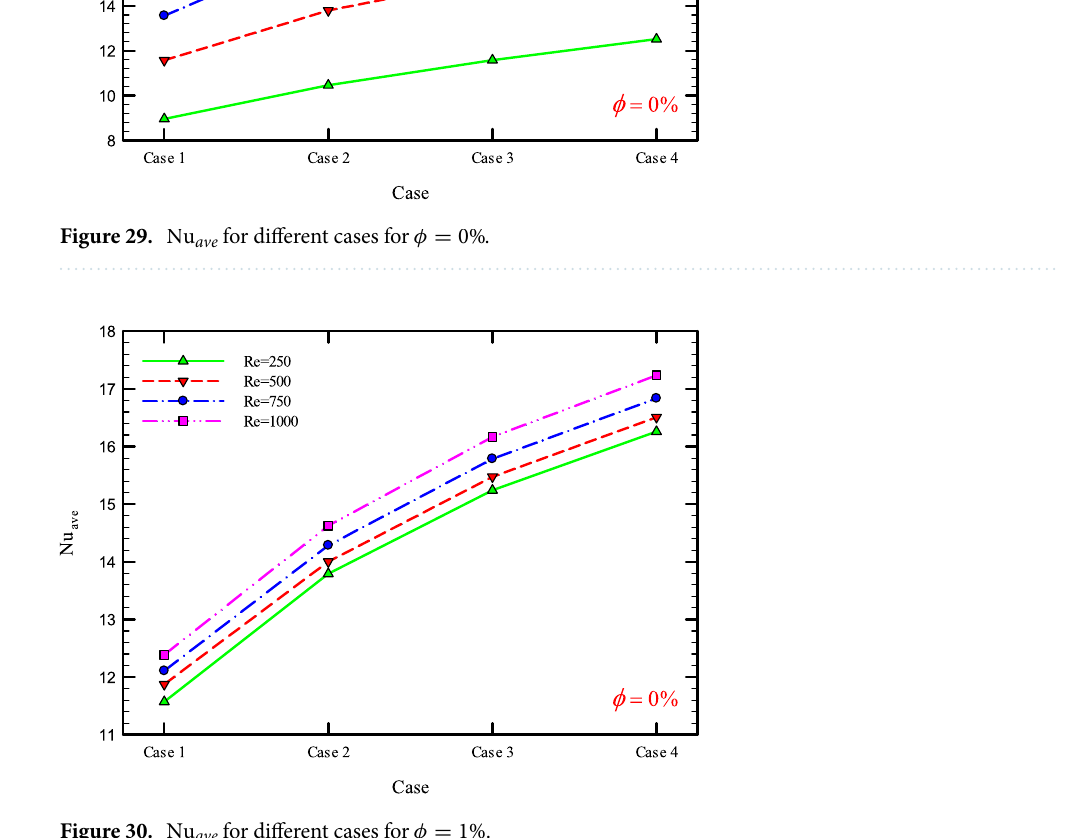
Figure 30. Nu ave for different cases for φ = 1%.